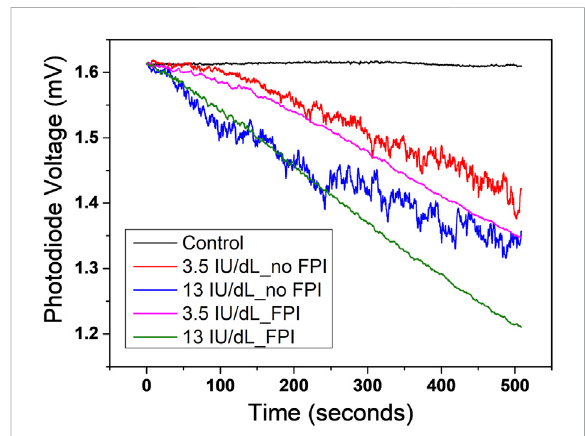
FIGURE 6 Comparison of the reaction curves with and without the addition of fi brin polymerization inhibitor (FPI). The chromogenic assay with undiluted plasma produces noisy signals (red and blue curves in the fi gure) owing to the generation of cross-linked fi brin. Experiments con fi rmed that the addition of FPI dramatically reduced the noise level and at the same time did not affect the assay reaction (magenta and green curves in the fi gure).